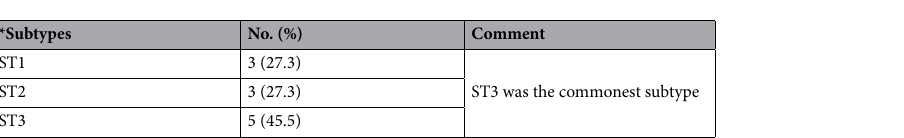
Figure 2. Parasitic stages associated with Blastocystis infection. ( a ) Blastocystis sp. vacuolar and intermediate- phase (arrowhead) form; ( b ) Chilomastix mesnili cyst (arrow) mixed with Blastocystis sp. cyst (arrowhead); ( c ) Entamoeba coli cyst; ( d ) Giardia duodenalis cyst; e: Entamoeba histolytica / dispar / moshkovskii cyst; ( f ) Hymenolepis nana egg. Photos a–e were taken with × 100; photo f was taken with × 40.